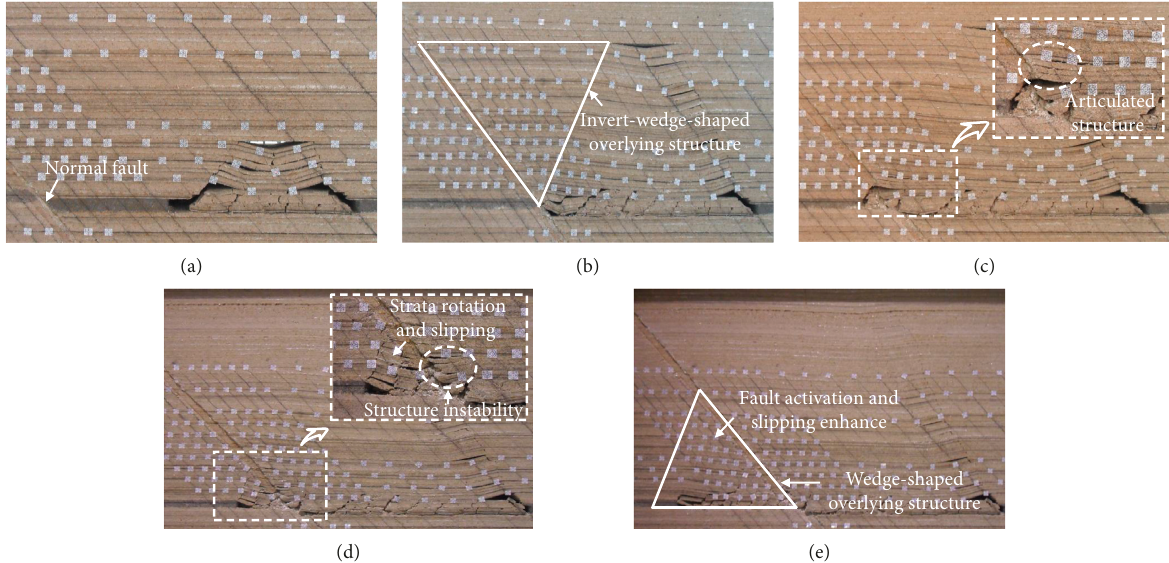
Figure 4: Structure evolution of overlying strata with mining from the hanging wall (Model 2). (a) L (d) L H � − 40m. (e) L H � −